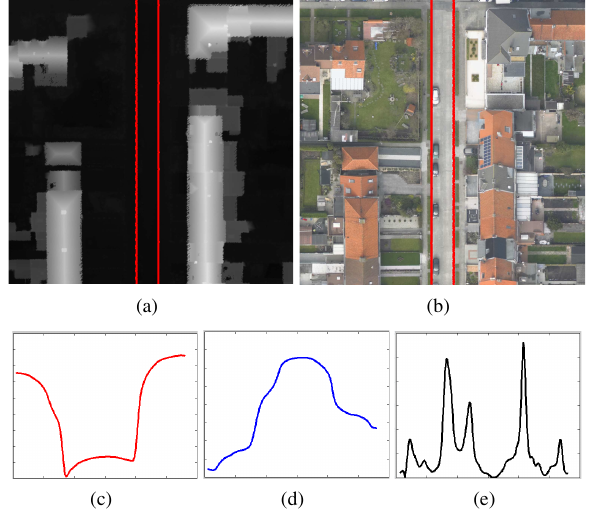
Figure 3: Projection of the points within each segment on a plane perpendicular to the main orientation of the segment. (a) A road depicted on the LiDAR image, (b) The same road depicted on the aerial image, (c) The road profile obtained from the LiDAR image, (d) The road profile obtained from the aerial image, (d) The first derivative of the integrated road